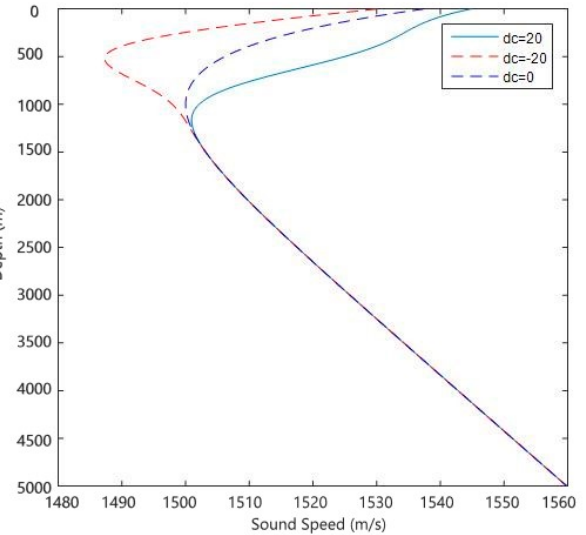
Figure 12. Distribution of the deep-sea sound channel in the vertical section of the vortex center.